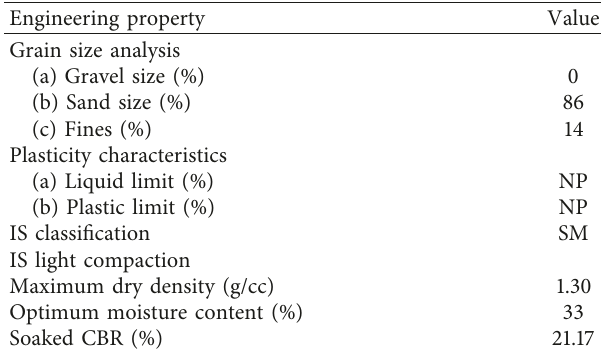
Table 2: Engineering properties of brick powder.